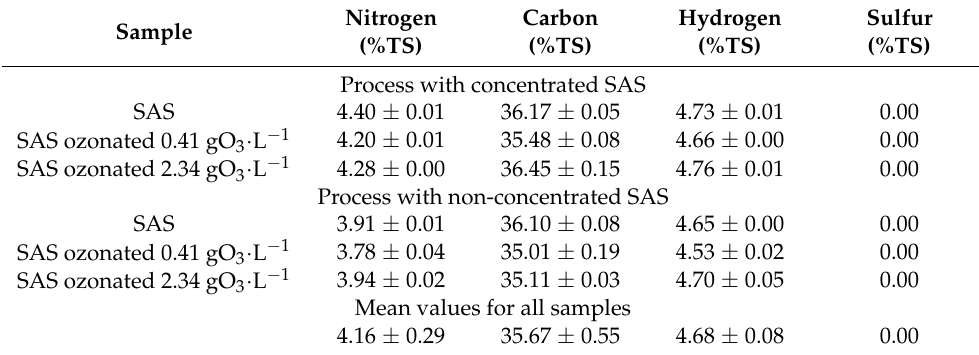
Table 1. Results of elemental analysis.